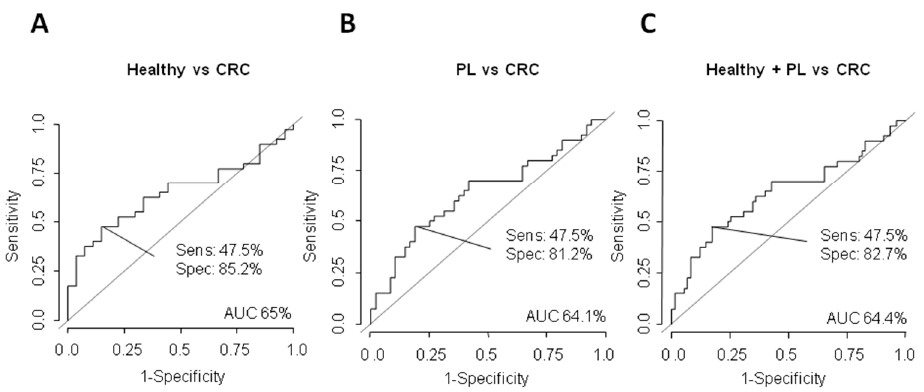
subjects ( C ) was carried out through ROC curves calculating AUC, its specificity (spec) and calculating AUC, its specificity (spec) and sensitivity (sens). sensitivity (sens).